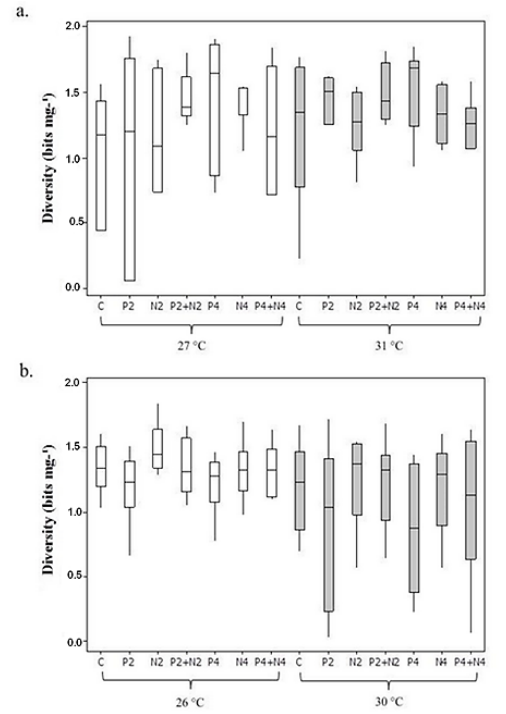
Figure 3. Variation (medians and quartiles, n = 8) of the diversity (bits mg -1 ) of the phytoplankton community in different nutritional enrichment and temperature treatments, for the rainy season (a) and dry season (b). White bars represent the temperature control treatments and the ashes the warming temperature